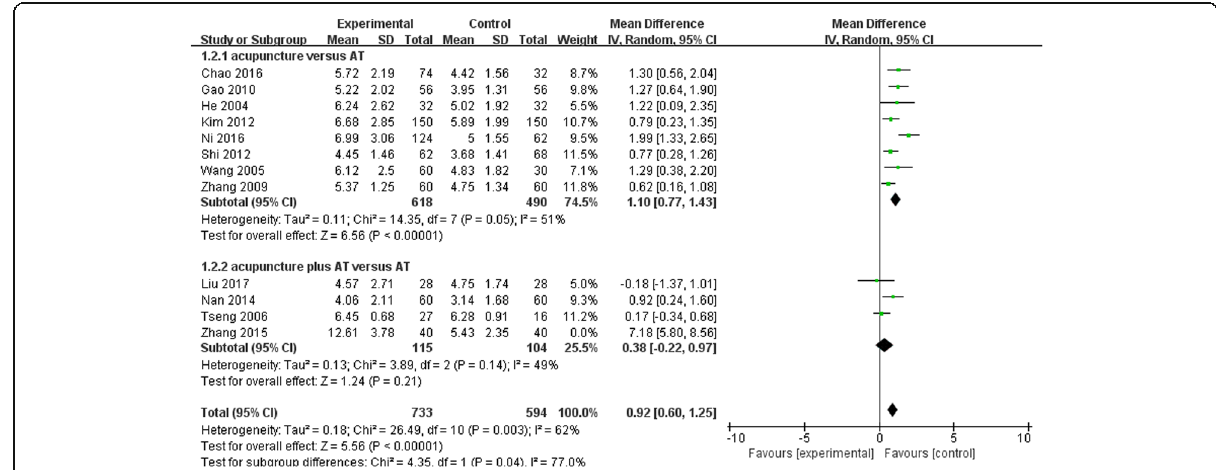
Fig. 3 Break up time (BUT) comparison between acupuncture and artificial tears (AT): Random effect model